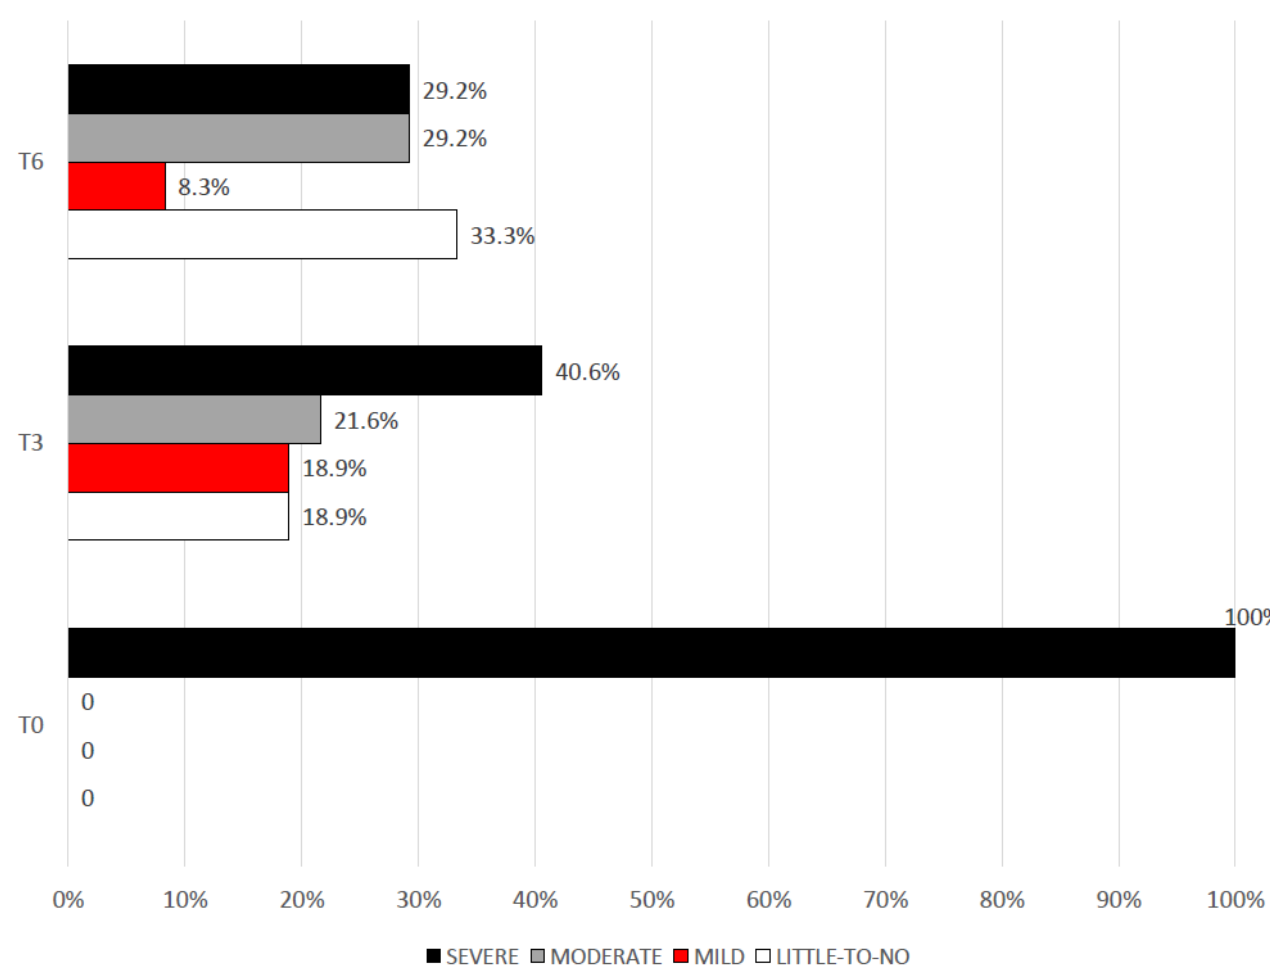
Figure 2. Degrees of migraine disability (MIDAS score) from the baseline and following 3 (T3) and 6 (T6) months of 6 (T6) months of treatment.